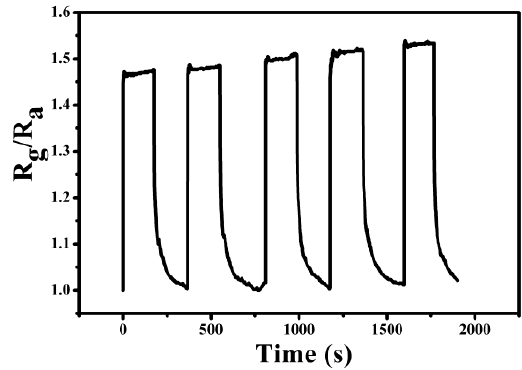
Figure 3. ( A ) Response of PPy–PAN nanoyarn exposed to different ammonia concentrations. ( B ) The linear relationship between the sensitivity of the PPy–PAN nanoyarn and different ammonia concentrations. (The concentration of p -toluenesulfonic acid ( p -TSA) was 0.004 M).